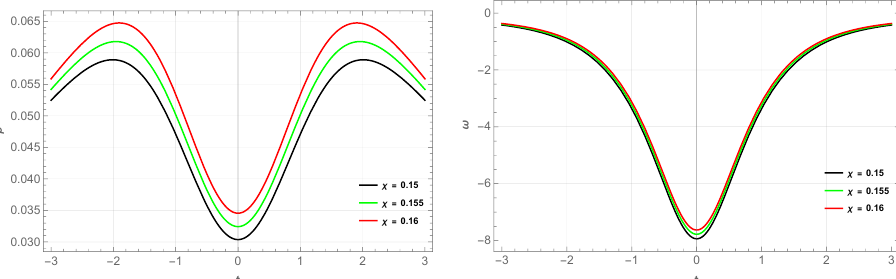
Figure 2. Behavior of energy density ( left panel ) and EoS parameter ( right panel ) versus cosmic time t for α = − 0.30, β =